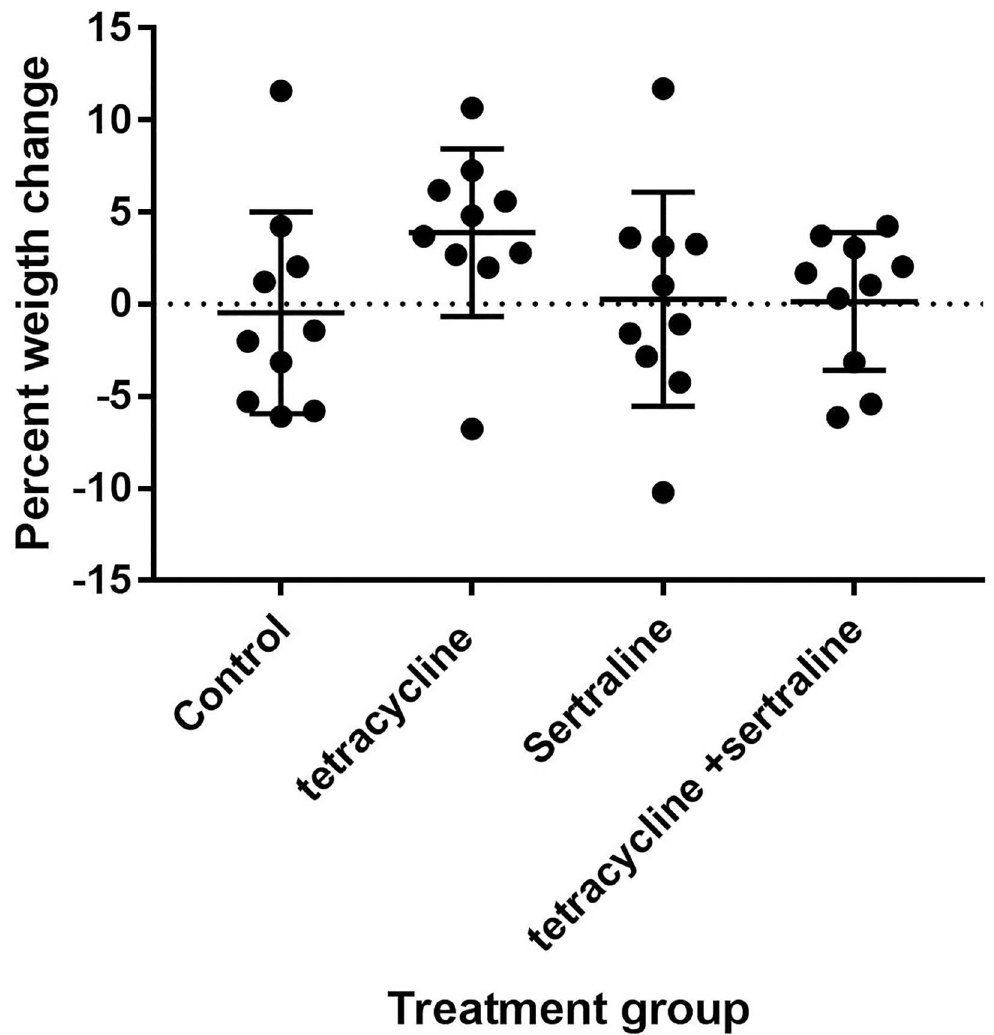
Fig 1. Weight changes during infection. Percent weight changeseven days after infection comparedto before infectionper chicken in the different treatment groups.